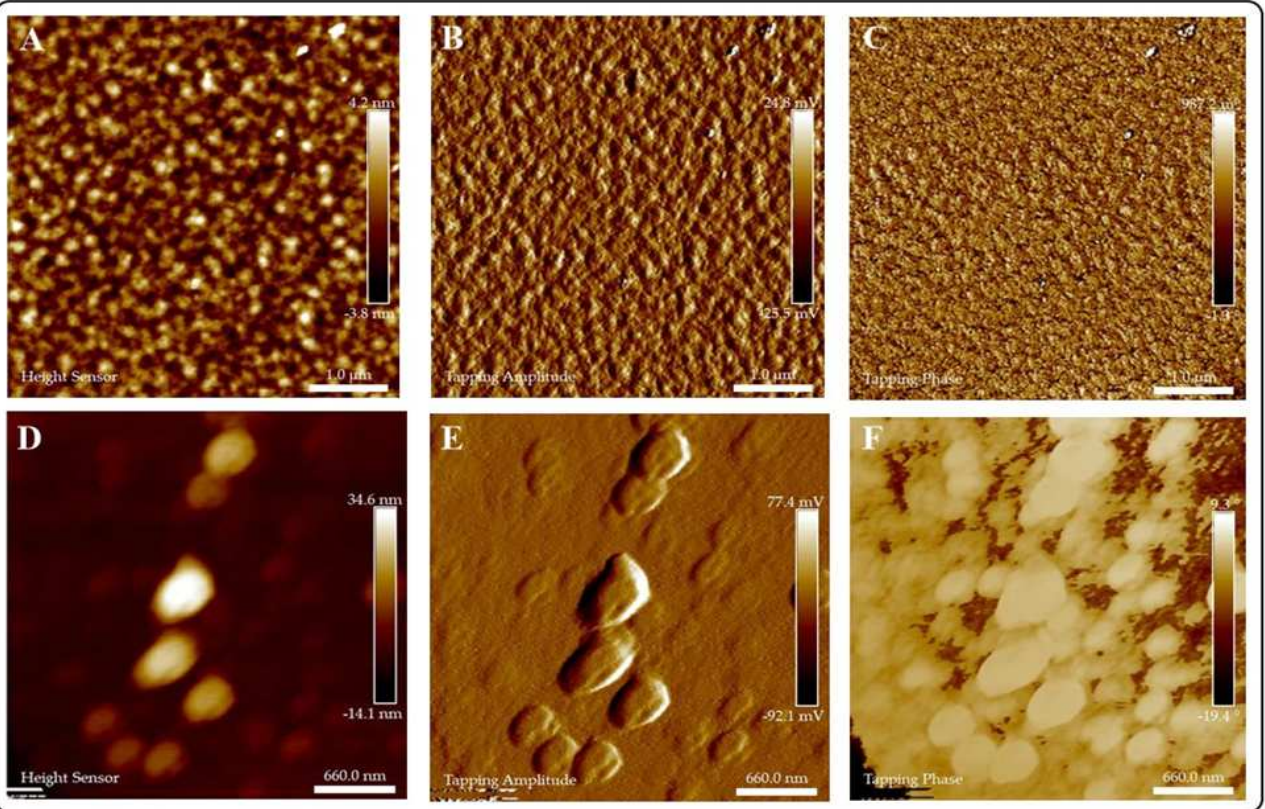
Figure 4. AFM analysis of Arabic gum (AG) and CuI@AG films. ( A – C ) Arabic gum thin films; height, amplitude and phase analysis, respectively. ( D – F ) CuI@AG thin films; height, amplitude and phase analysis,